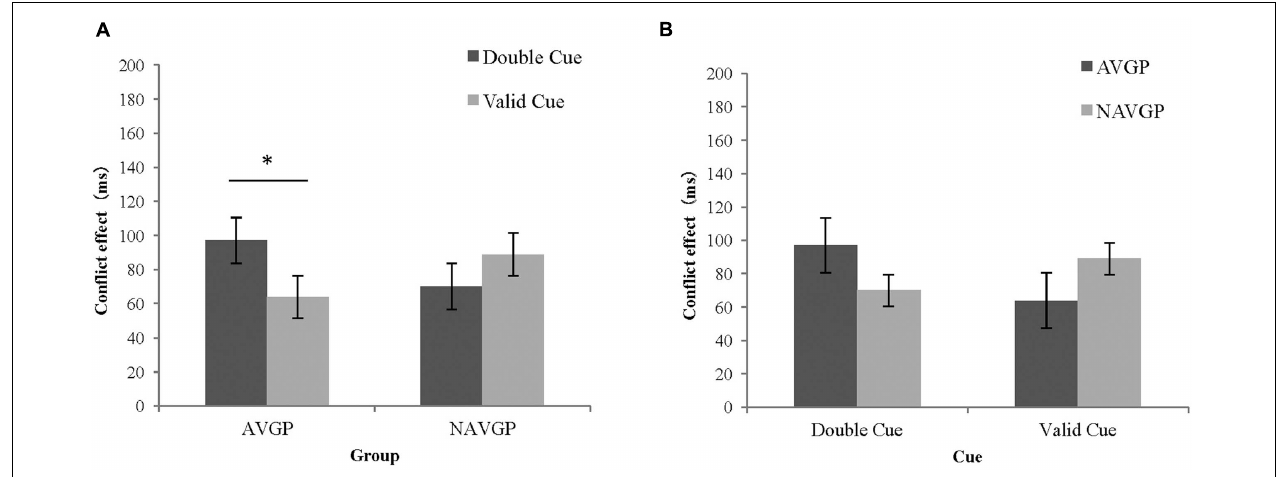
FIGURE 6 | Conflict effects of different groups under different cue conditions in the ANT-A (A) The conflict effects in AVGPs and NAVGPs under double cues and valid cues; (B) The conflict effects in AVGPs and NAVGPs under double cues and valid cues. Error bars represent the standard error of the mean. ∗ p < 0.05. TABLE 6 | Correlation coefficients for the attentional effects in different groups in the ANT-A. Group Overall Alerting Disengaging Orienting Validity Conflict A × C D × C O ×